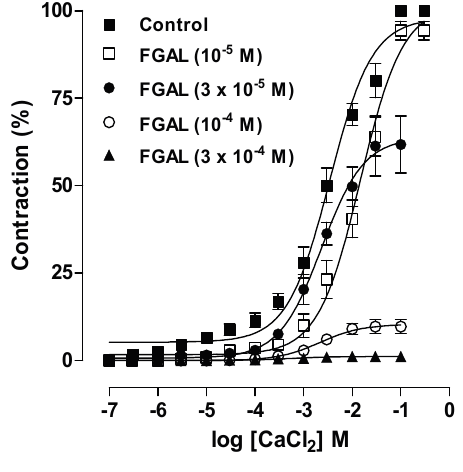
Figure 6. Cumulative concentration-response curves to CaCl 2 in depolarizing medium (high K + ) nominally without Ca 2+ in both the absence ( ■ , control, n = 5) and presence of 10 − 5 ( □ , n = 5), 3 × 10 − 5 ( ● , n = 5), 10 − 4 ( ○ , n = 5) and 3 × 10 − 4 M ( ▲ , n = 5) of FGAL. Symbols and vertical bars represent the mean and S.E.M.,